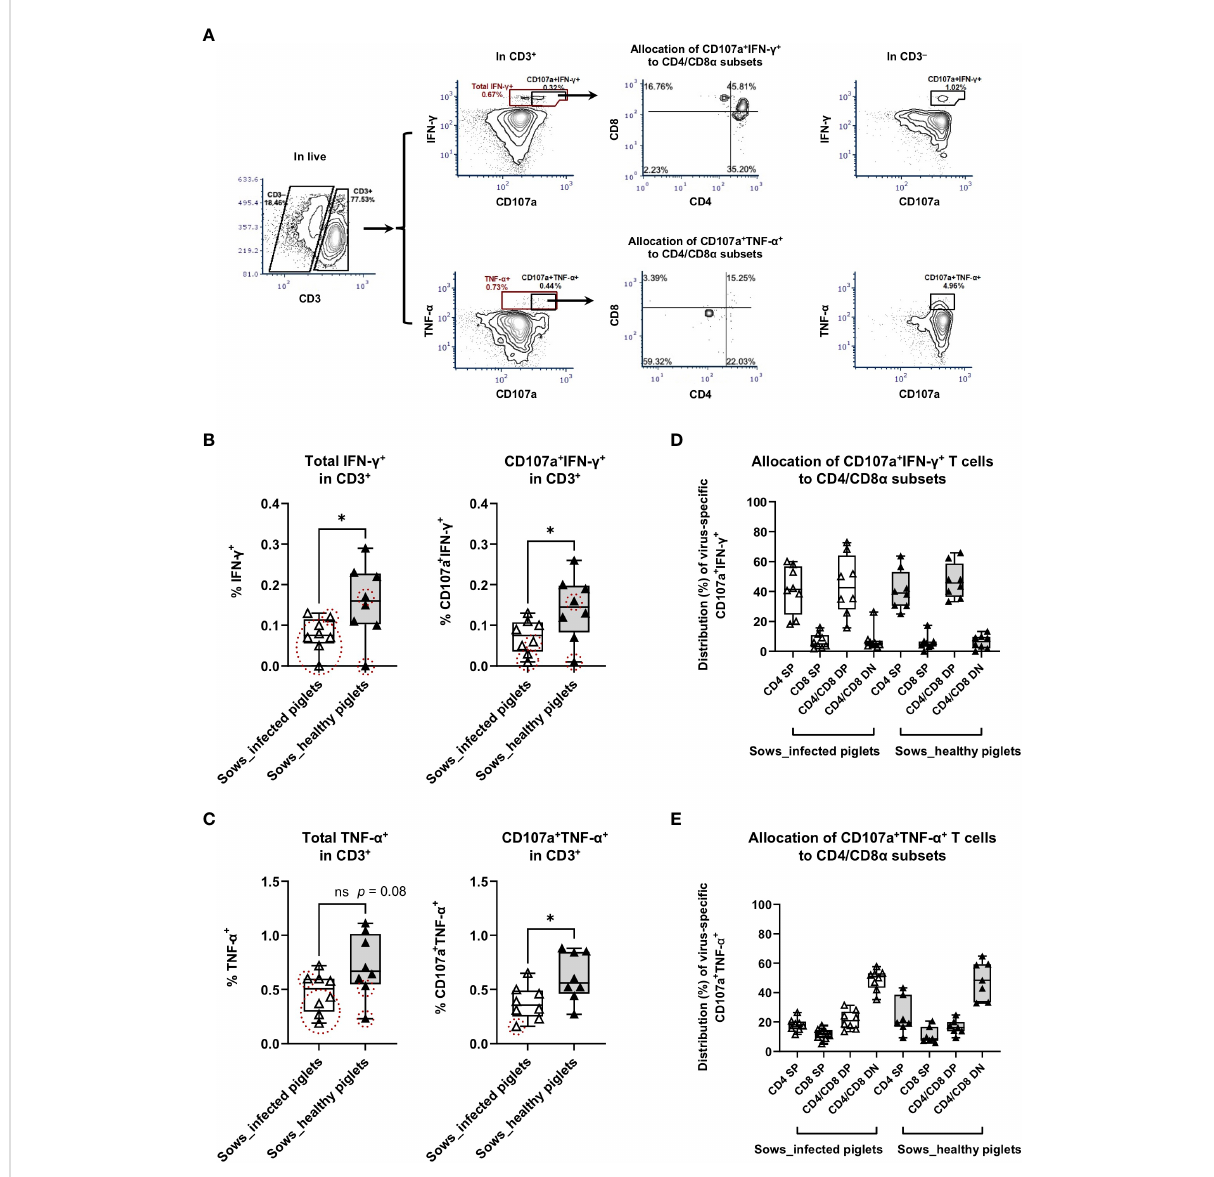
FIGURE 3 Virus-speci fi c IFN- g and TNF- a responses as measured by intracellular cytokine staining assays. PBMC from sows with or without the occurrence of transplacental infection were stimulated with PRRSV-1 JA2 strain in vitro for 8 h in the presence of anti-CD107a and anti-CD28 antibodies and with brefeldin A and monensin added for the fi nal 4 h. After that, cells were stained for live/dead Near-IR, CD3/CD4/CD8 a , and intracellular IFN- g or TNF- a . (A) Gating hierarchy to identify virus-speci fi c IFN- g - and TNF- a -producing T cells with cell degranulation: exclusion of debris ! singlets ! live cells ! CD3 + /CD3 – ! total IFN- g + or CD107a + IFN- g + , total TNF- a + or CD107a + TNF- a + ! CD4/CD8 a ; (B) Virus- speci fi c IFN- g responses and (C) virus-speci fi c TNF- a responses in T cells (CD3 + ). The graph shows the proportion of total IFN- g -producing and CD107a + IFN- g -producing T cells, total TNF- a -producing and CD107a + TNF- a -producing T cells in PRRSV-1 JA2-stimulated cultures. Sixteen sows (8 per group) were included. Each symbol, representing one sow, was the mean percentage of two replicas with background (cultures in the absence of PRRSV-1 JA2 stimulation) subtracted. Empty boxes (empty triangles) represent sows delivering infected fetuses; solid boxes (solid triangles) represent sows delivering healthy piglets. Symbols marked by dashed circles (in red) mean the frequency of IFN- g - or CD107a + IFN- g - producing, or TNF- a - or CD107a + TNF- a -producing T cells in JA2-stimulated cells was < 2-fold that of mock-stimulated cells; Allocation of virus-speci fi c (D) CD107a + IFN- g -producing T cells and (E) CD107a + TNF- a -producing T cells to CD4/CD8 a subsets. Statistical signi fi cance was measured by the Mann – Whitney nonparametric test. * p <